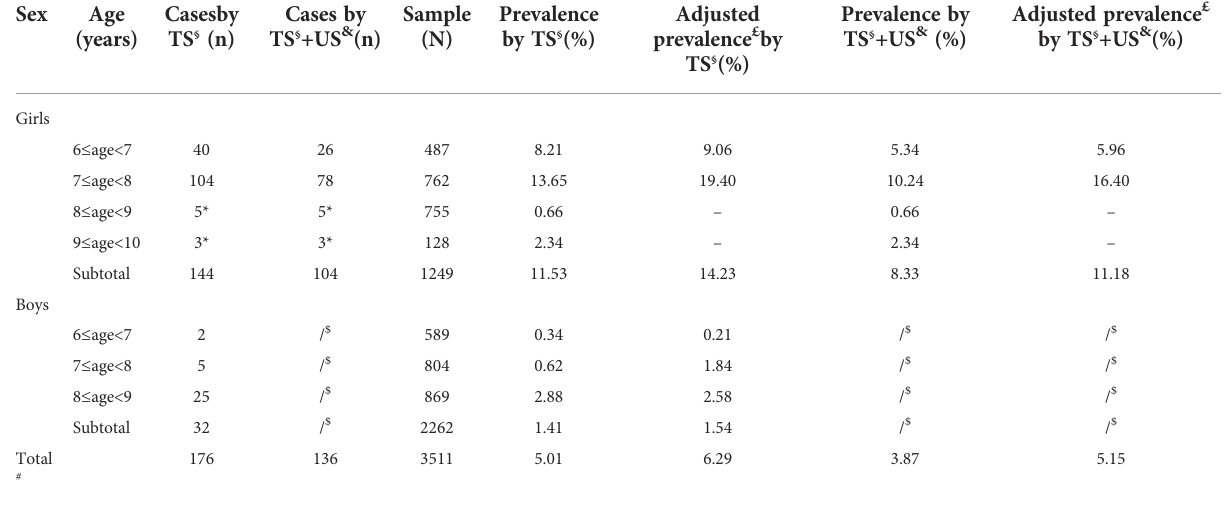
TABLE 2 Prevalence of precocious puberty of children in Qufu, Shandong,